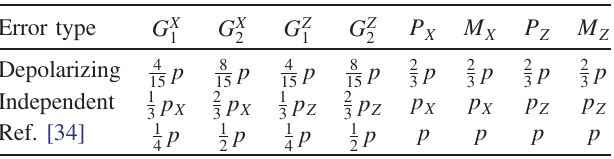
TABLE II. The probability of a fault occurring for each type of circuit element under the two error models considered in this work, as well as for the depolarizing error model used in Ref. [34] for